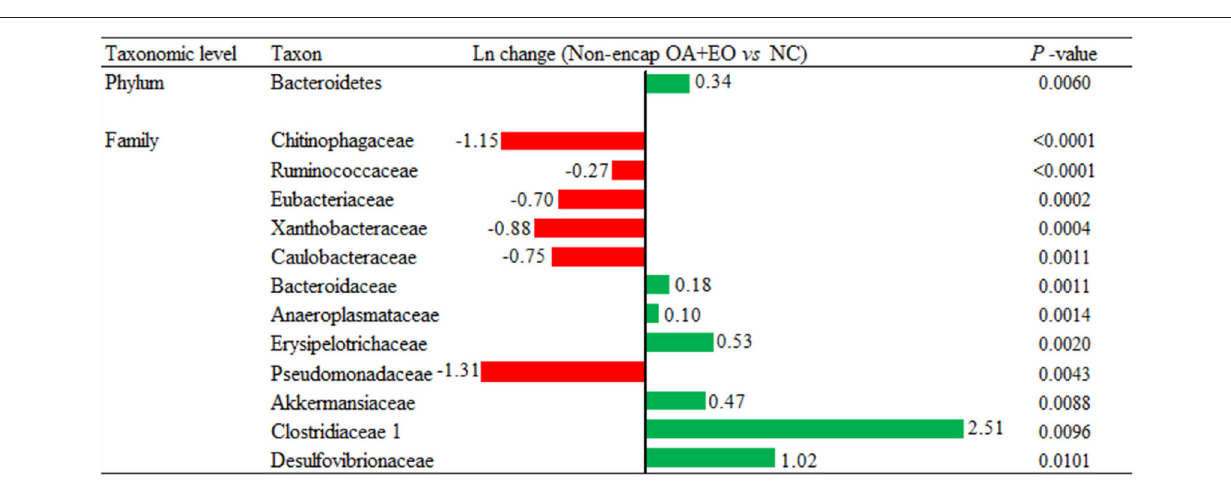
FIGURE 7 | Ln changes promoted by the supplementation of the non-encapsulated mixture of fumaric acid and thymol as compared to the NC (fold discovery rate P -adjusted < 0.05) in taxa. Positive values ( ) and negative values ( ) indicate greater and lower abundance. Only significant taxa are presented. Differences presented are based on all taxa detected in samples per diet. NC, negative control; OA, organic acid: fumaric; EO, essential oil: thymol. Non-encap: non-microencapsulated. Inclusion levels: non-microencapsulated fumaric acid: 0.9 g/kg; non-microencapsulated thymol: 0.6